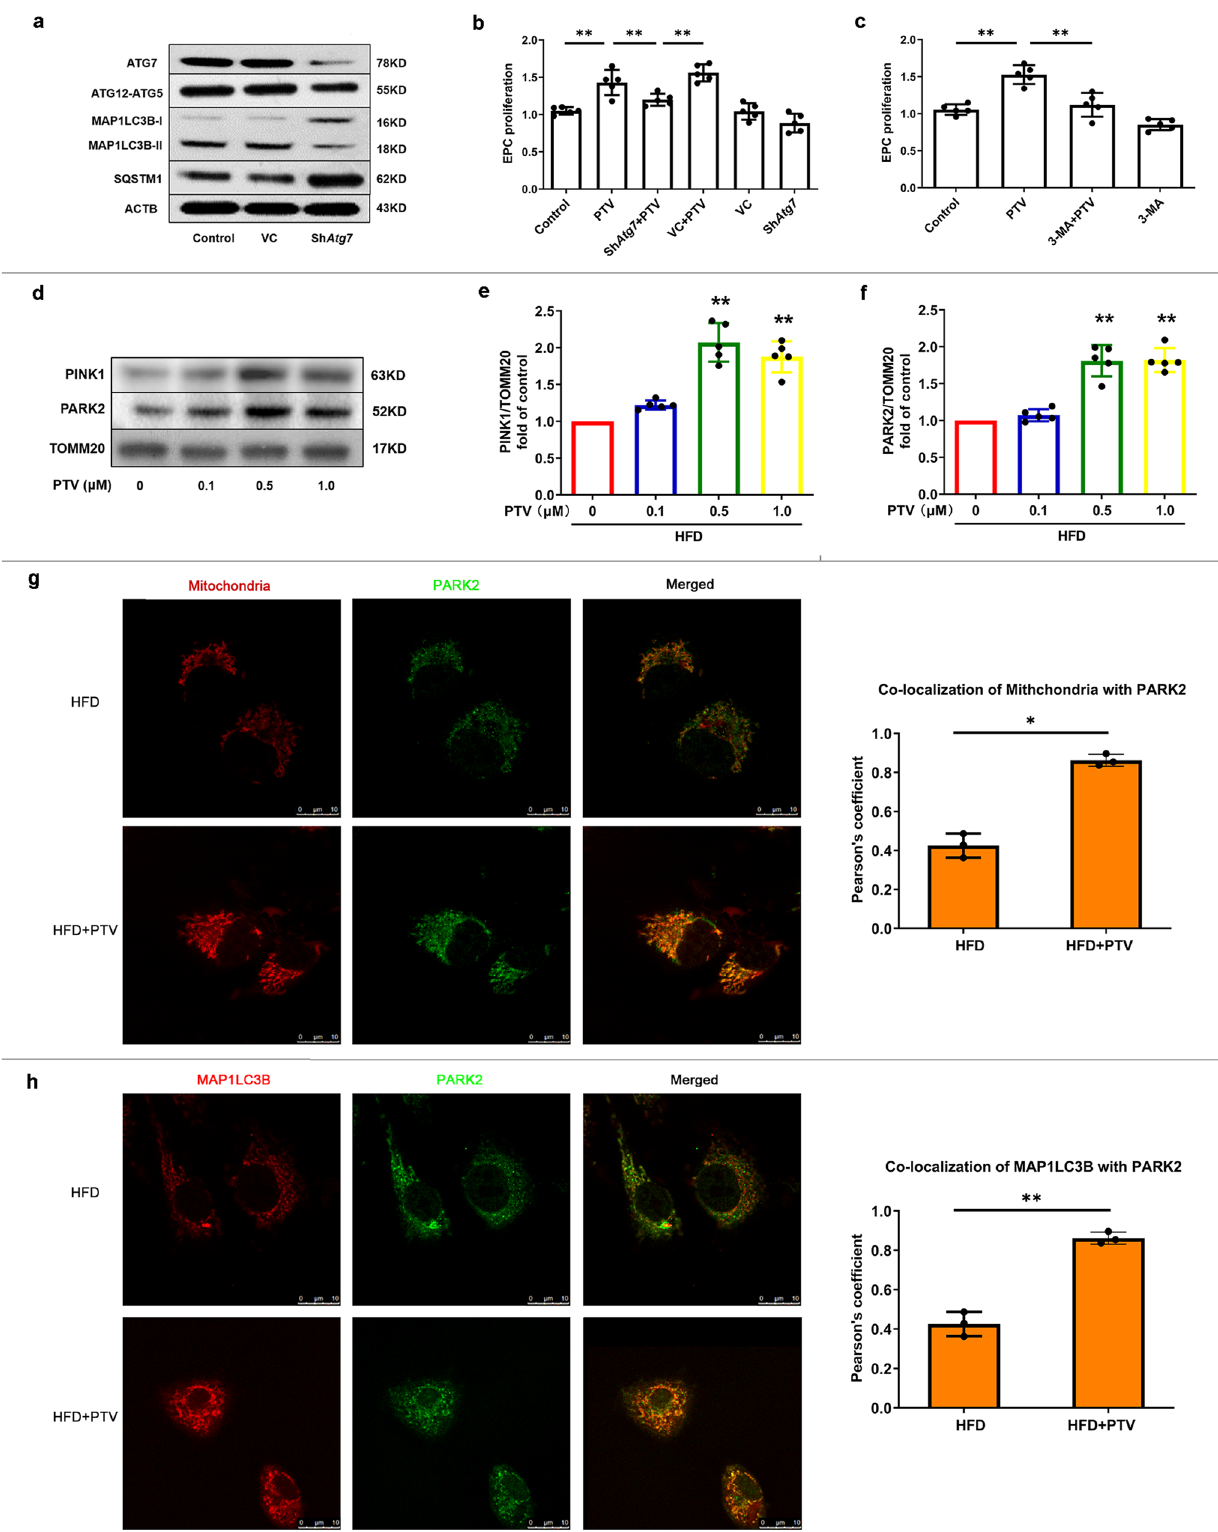
home to carotid artery intima in comparison to PTV and PTV + VC groups (Fig. 9a, white arrow). Furthermore, Evans Blue staining was performed to evaluate the reendothelialized area after EPC transplantation in mice. As shown in Fig. 9b, the reendothelialized area in PTV group was signi fi cantly larger than